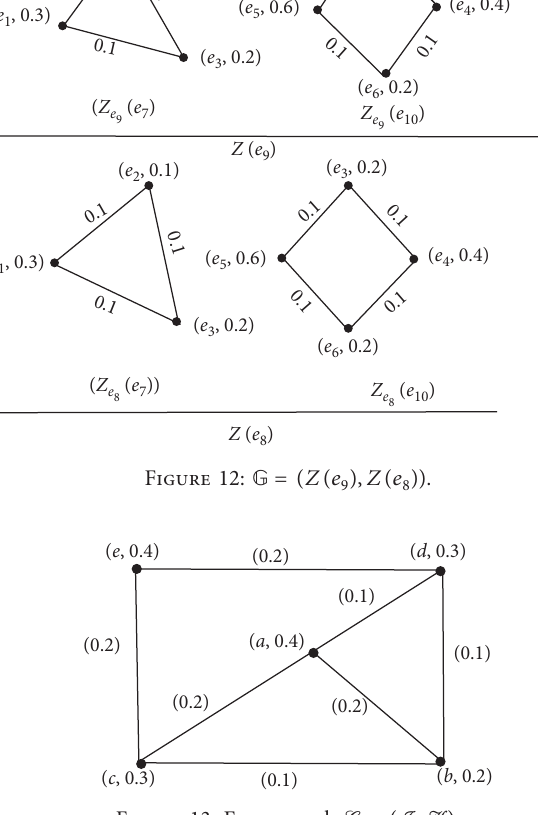
Figure 13: Fuzzy graph G � ( J , K )